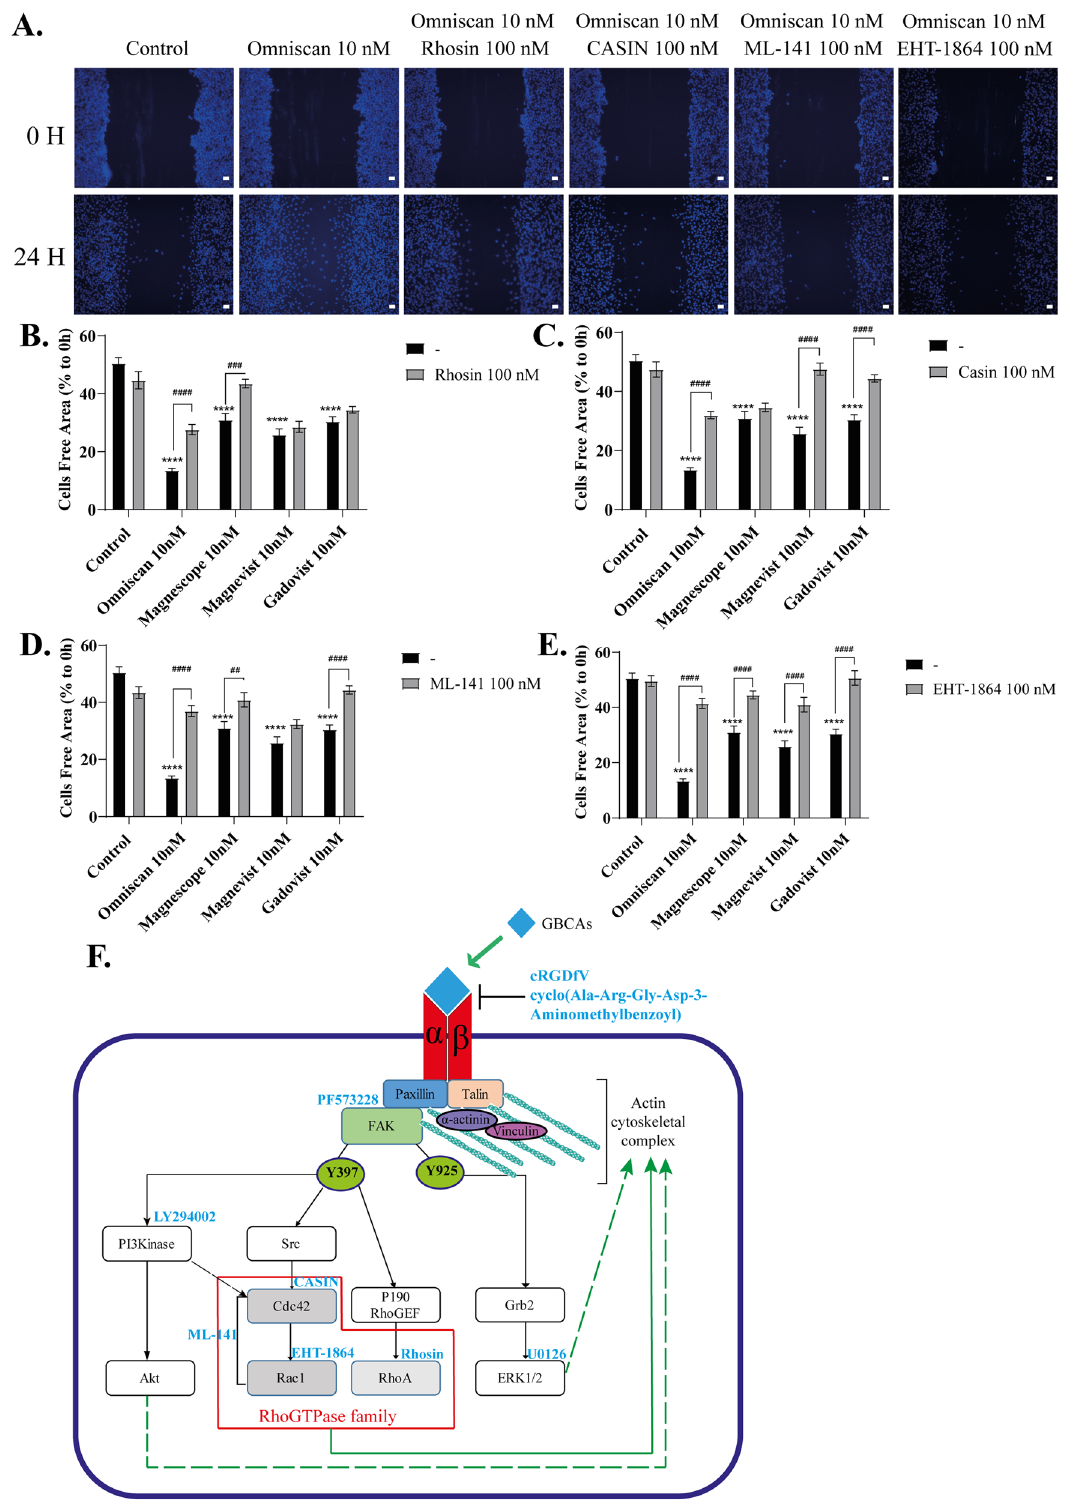
Figure 8. GBCAs increased astrocytes migration via RhoGTPase signalling pathway. ( A ) Representative photomicrographs showing the effects of Rhosin, a RhoA inhibitor, CASIN, a Cdc42 inhibitor, ML–141, a Rac1/ Cdc42 inhibitor, and/or EHT-1864, a Rac1 inhibitor, on Omniscan-accelerated C6 cell migration measured using a wound-healing assay. ( D - E ) Quantitative analysis of the effects of Rhosin, CASIN, ML–141, and/or EHT–1864 on GBCAs-accelerated cell migration, measured using wound healing assays using C6 cells. ( F ) The proposed mechanism of GBCAs effect in astrocyte migration. Bars represent 50 μm. Data are expressed as the mean ± SEM of at least three independent experiments. **** p < 0.0001, indicates statistical significance were analysed by two-way ANOVA continued with post hoc Bonferroni’s or Turkey test compared with the control. #### p < 0.0001, ### p < 0.001, ## p < 0.01, indicates statistical significance were analysed by two-way ANOVA continued with post hoc Bonferroni’s or